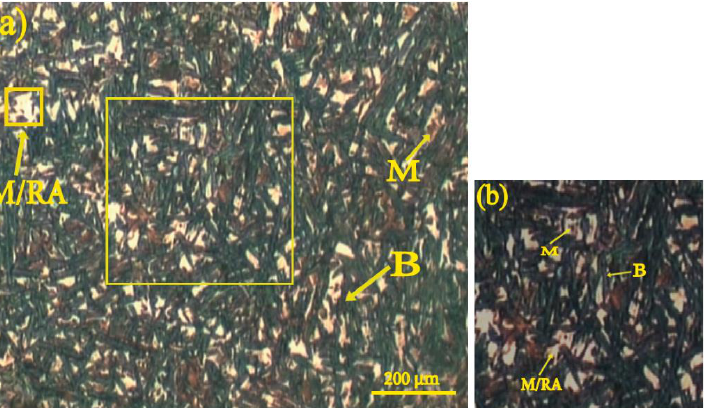
Figure 4. ( a ) Double-step II etching method (10% ammonium persulfate solution + warm Marble’s reagent at 30 ◦ C). ( b ) Enlarged image view of the square shown in ( a ). The abbreviations B, M and M/RA represent bainite, martensite and martensite/retained austenite phase constituents,